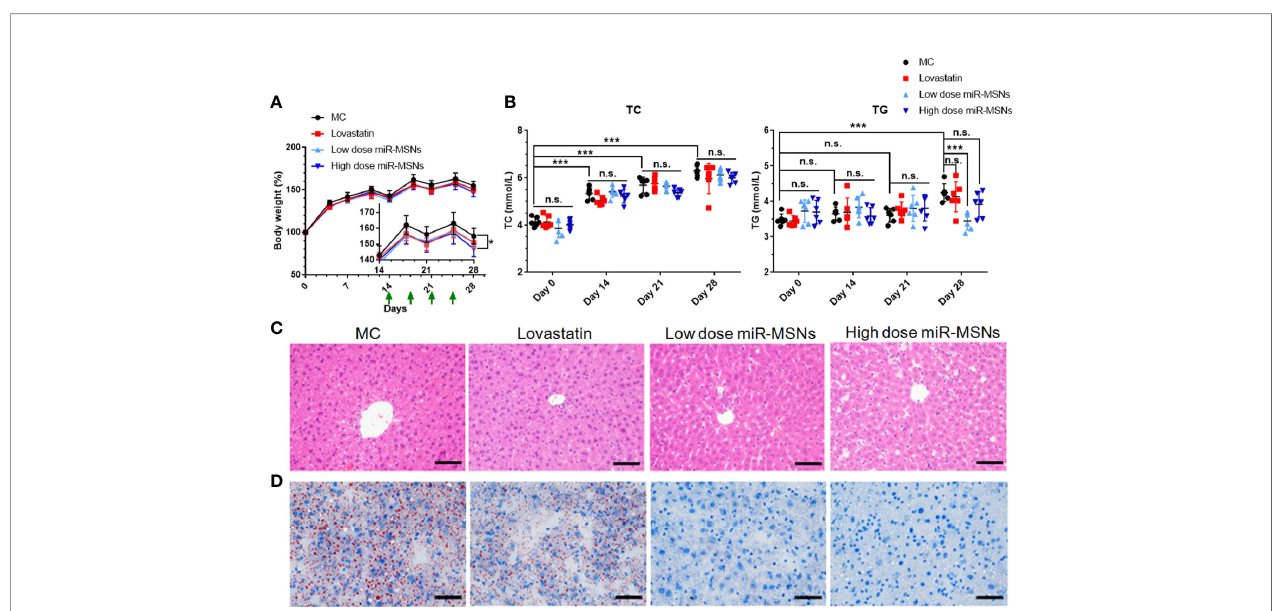
FIGURE 6 | Lipid-metabolism regulation ef fi cacy of miR-MSNs. n=6. (A) Weight change curve of HFD-fed C57BL/6J during the course of the study. (B) Concentration of TC and TG in the serum. (C) Representative photographs of HE-stained liver sections. Scale bar = 50 µm. (D) Representative photographs of Oil Red O stained liver sections. Scale bar = 50 µm. *p < 0.05, ***p <0.001. n.s., no signi fi